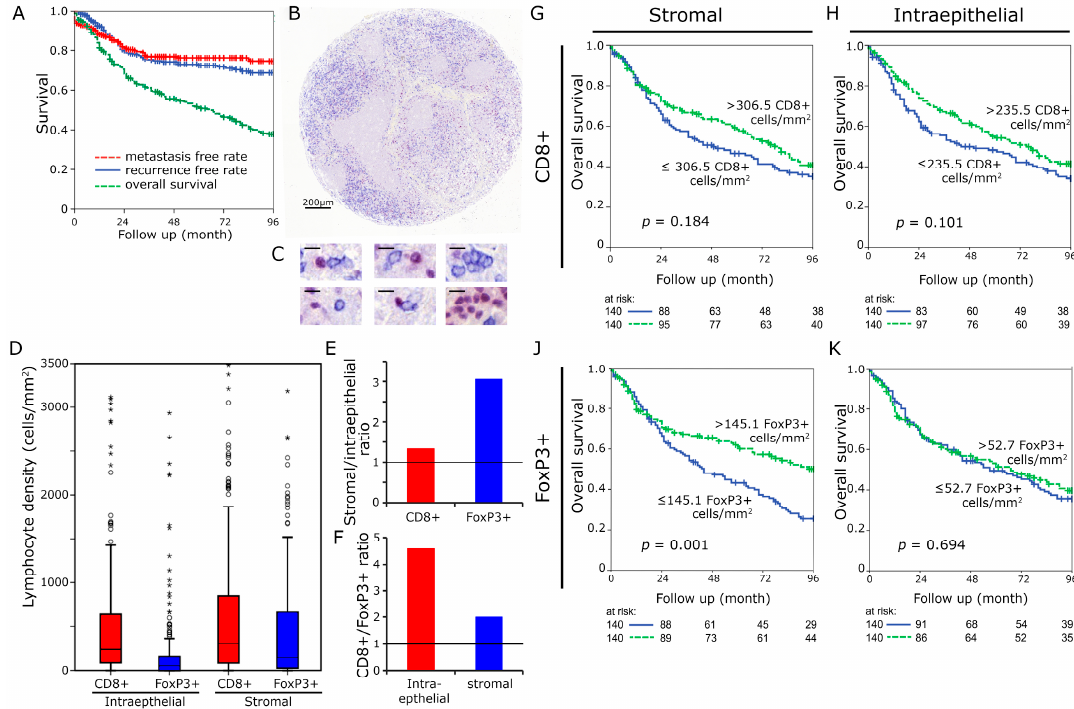
Figure 1. CD8+ and FoxP3+ cell densities in head and neck cancer. Kaplan Meier plots for metastasis free rate, recurrence free rate and overall survival in the complete cohort of 280 patients ( A ). Tissue samples were processed into tissue microarrays using a core diameter of 2 mm. Scale bar 200 µm ( B ). High power views (1:400) with immunohistochemical double staining for FoxP3 (red nucleic staining) and CD8 (blue predominantly membranous staining). (Scale bars 10 µm) ( C ). Lymphocyte densities (cells/mm²) in the intraepithelial and stromal compartment were separately analyzed ( D ). Stromal/intraepithelial ratio of CD8+ and FoxP3+ cells ( E ). CD8+/FoxP3+ ratio in intraepithelial and stromal compartment ( F ). Kaplan Meier plots for densities of CD8+ lymphocytes in the stromal ( G ) and intraepithelial H as well as FoxP3+ cells in the stromal ( J ) and epithelial ( K ) compartment (overall survival). Cut-off values were the median.